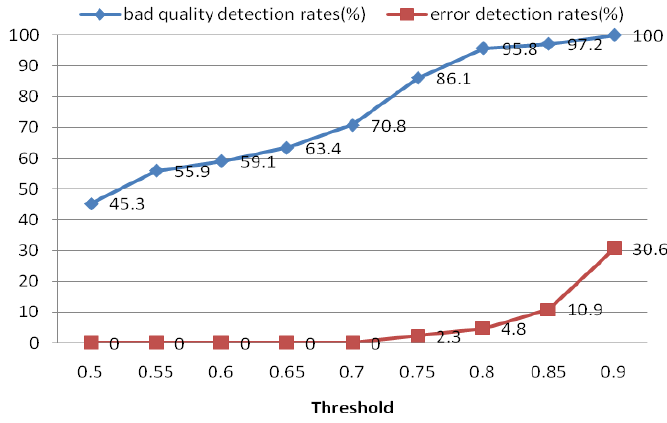
Figure 21. Detection rates for different quality measure thresholds.